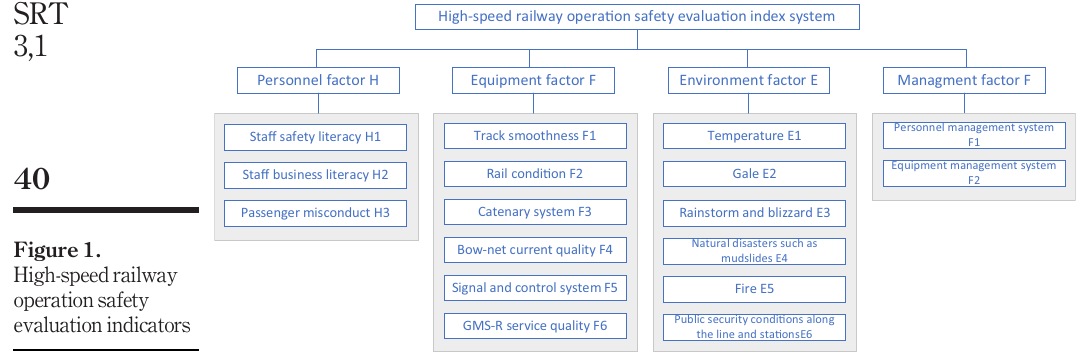
Figure 1. High-speed railway operation safety